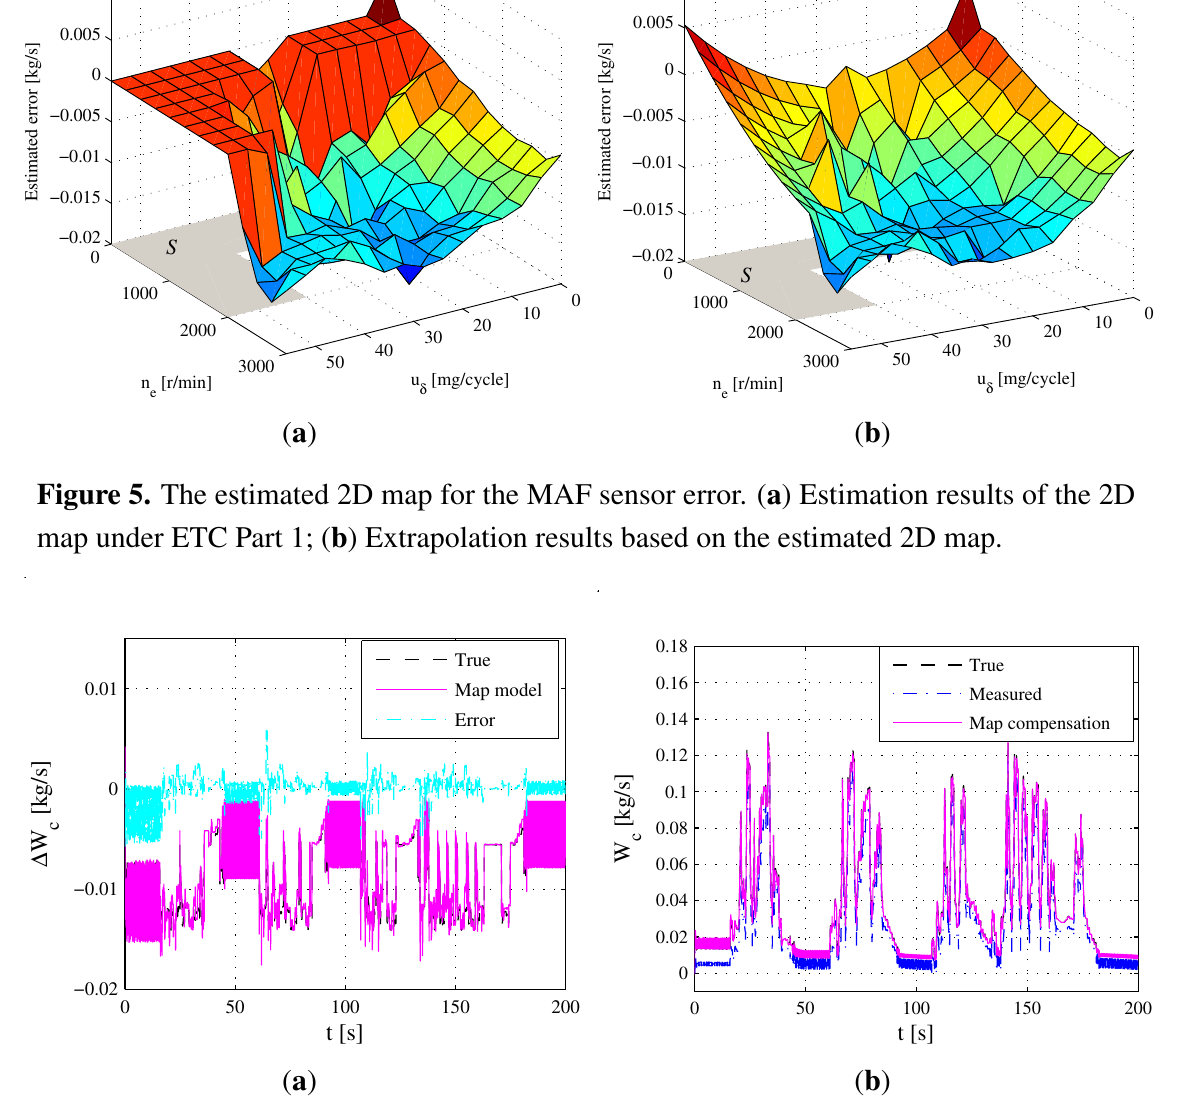
Figure 6. 2D map compensation during the ETC segment. ( a ) Simulation results between ( u , n ) and the estimated 2D map; ( b ) Simulation results of true mass reference error ∆ W c δ e air flow y , measured mass air flow y and the map 2 m 2